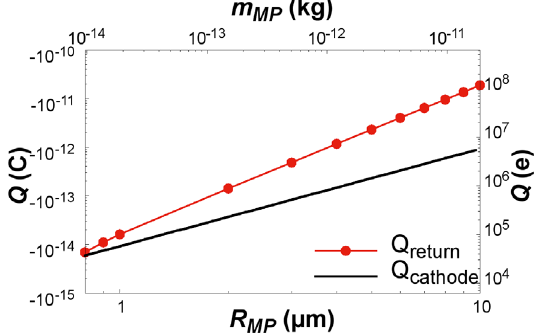
FIG. 14. Comparison of the charge necessary to stop and reverse the MP trajectory (Q equilibrium with the cathode for different. R